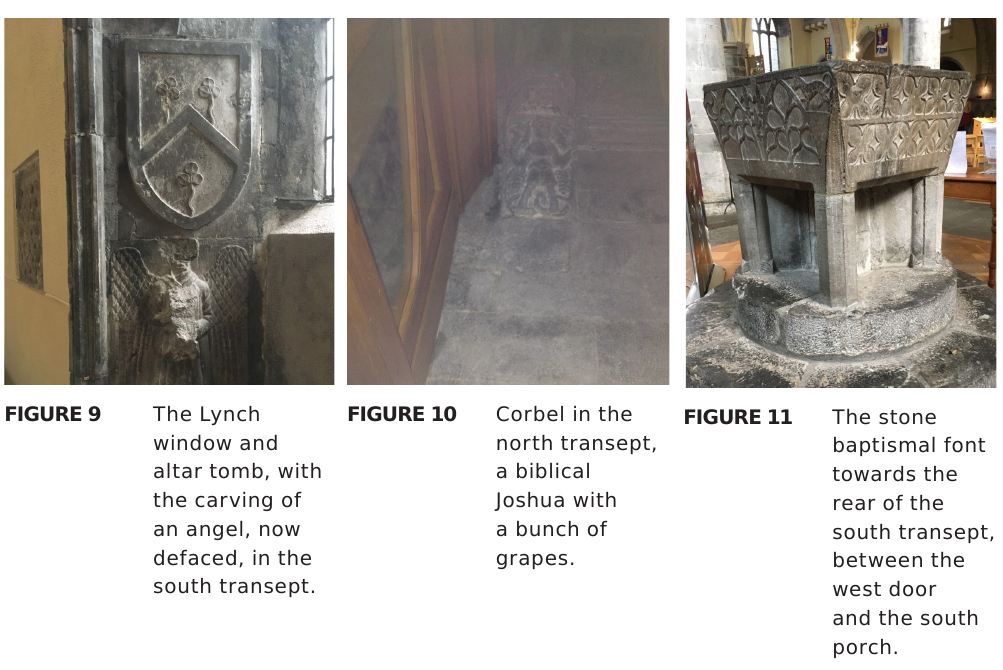
baptismal font towards the